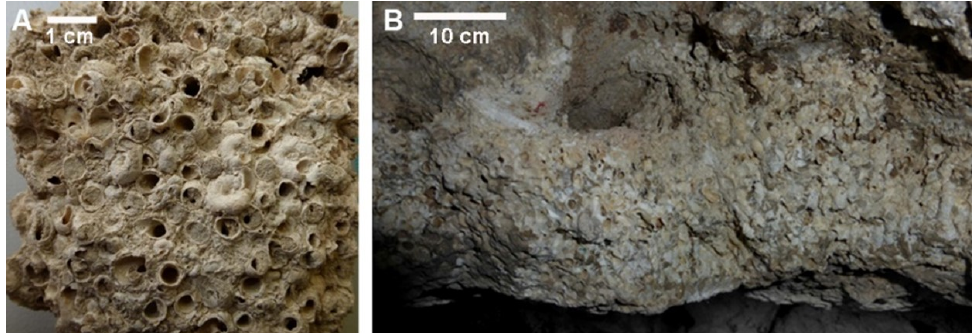
Figure 16. Dendropoma encrustations along the wall of the cave. ( A ) Detail of a Dendropoma crust with coiled shells. ( B ) Thick crust from the northern wall of the cave, with downfacing specimens having tubular shells slightly undulated and subparallel to each other.